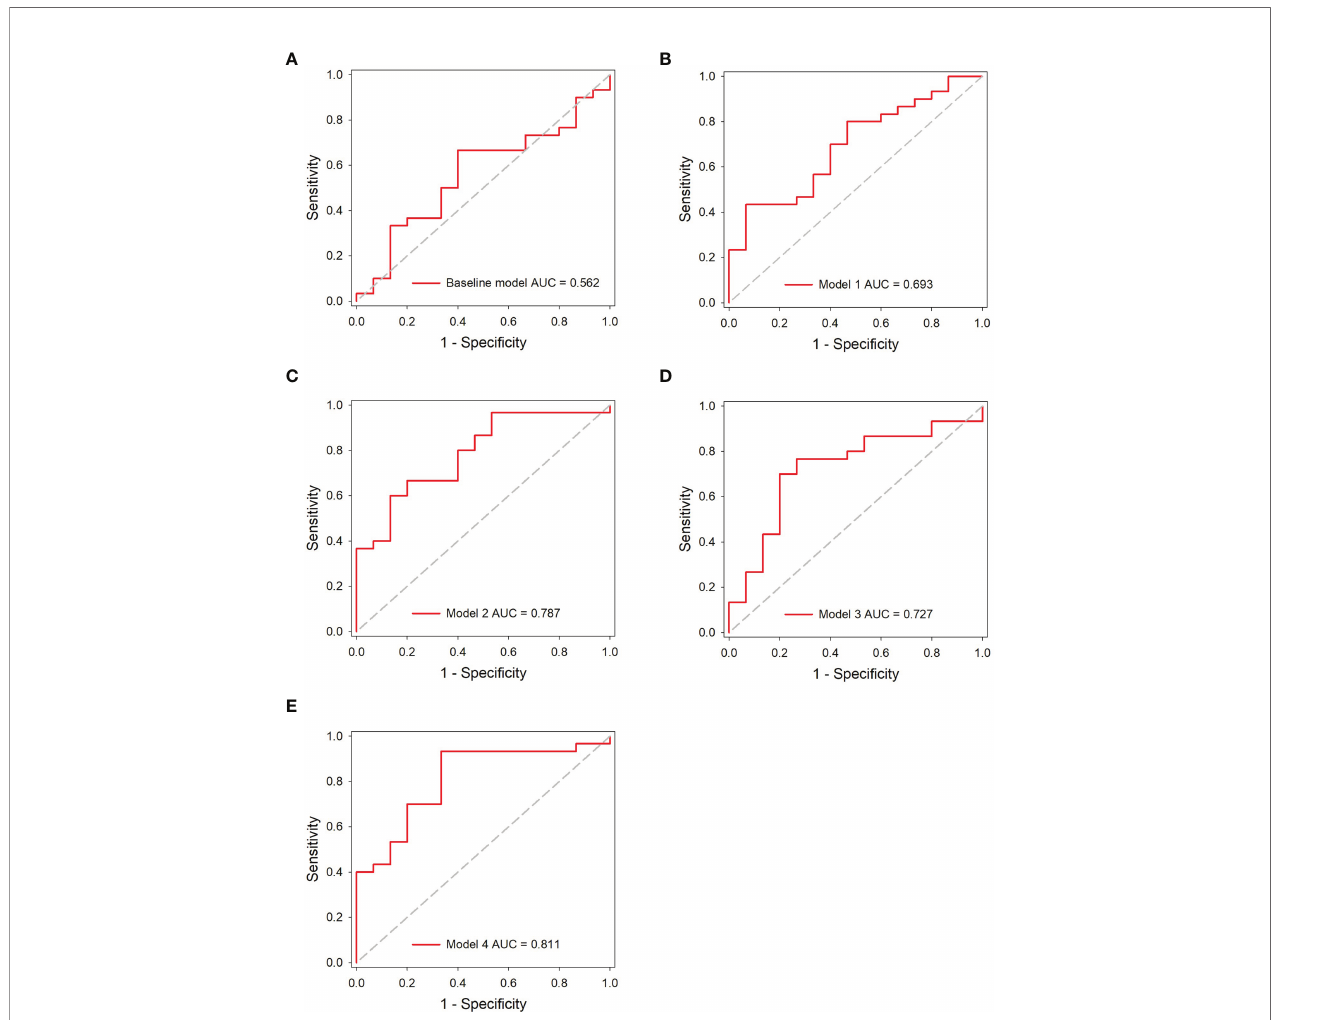
FIGURE 5 | ROC analysis of the predictive models in the independent testing dataset. (A) The baseline model. (B – E) The DL